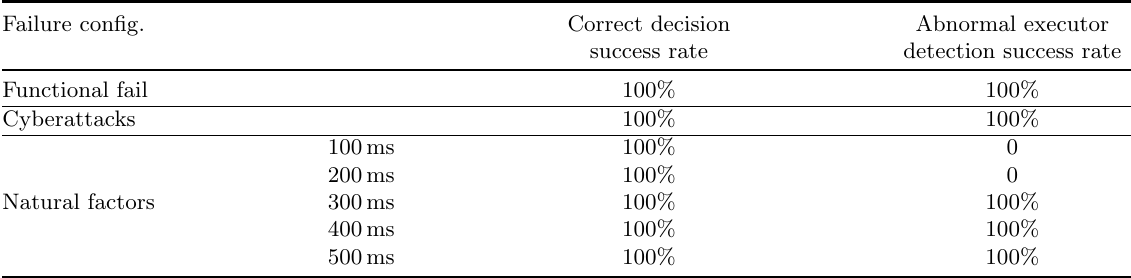
Table 2. Study results on the detection success